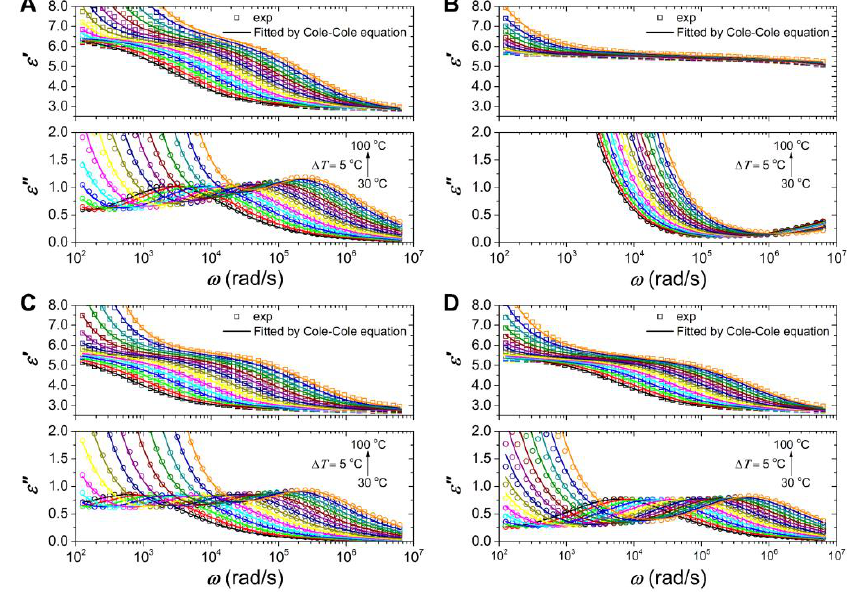
Figure 10. Dielectric relaxation spectra of the ER fluids at various temperatures: ( A ) neat PIL, ( B ) PIL/PANI(HCl), ( C ) PIL/PANI(NH 3 ), and ( D ) PIL/PANI(N 2 H 4 ).